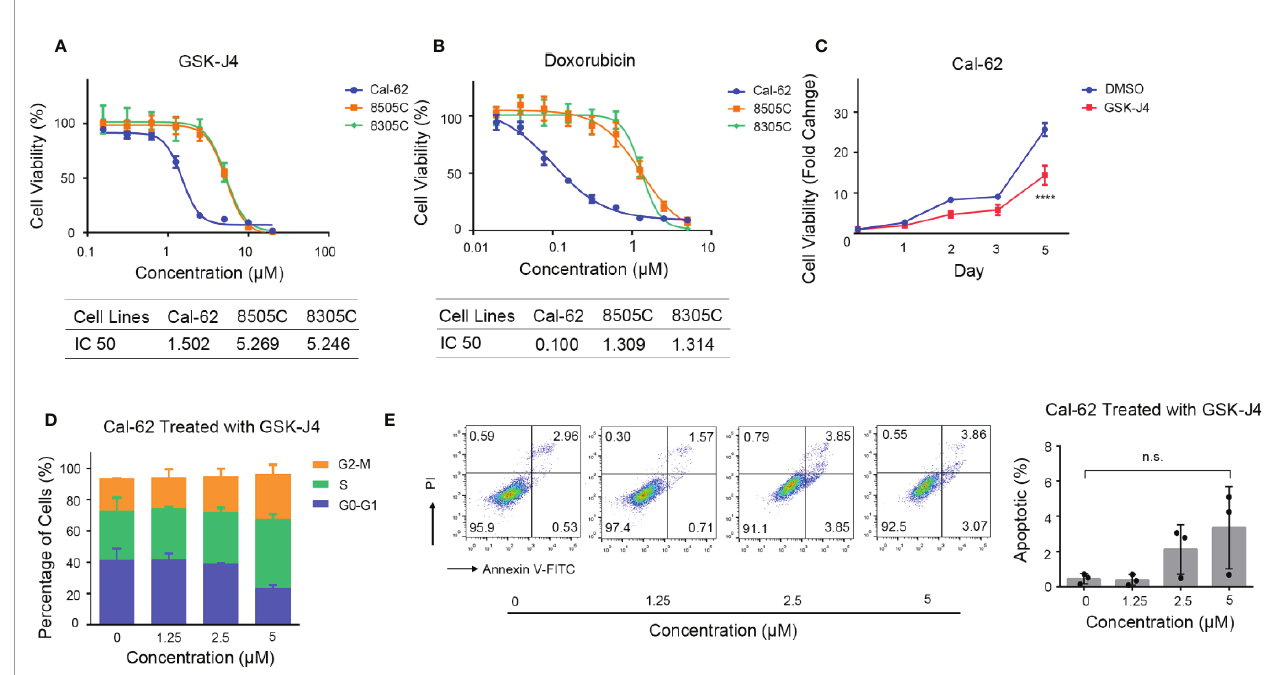
FIGURE 1 | Effect of GSK-J4 on the Cal-62 Anaplastic Thyroid Carcinoma Cell Line. The proliferation relationship between concentration of GSK-J4 (A) and doxorubicin (B) in anaplastic thyroid cancer cell lines. (C) Cal-62 cell proliferation in different treatment time of GSK-J4. Effects of GSK-J4 on the cell cycle (D) and apoptosis (E) in Cal-62 cells. IC50, half maximal inhibitory